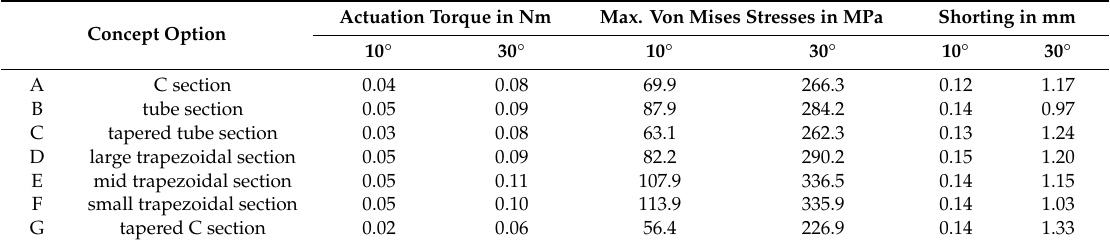
Table 12. Rotational torque, stresses, and parasitic shortening at one blade by 10 and 30 ◦